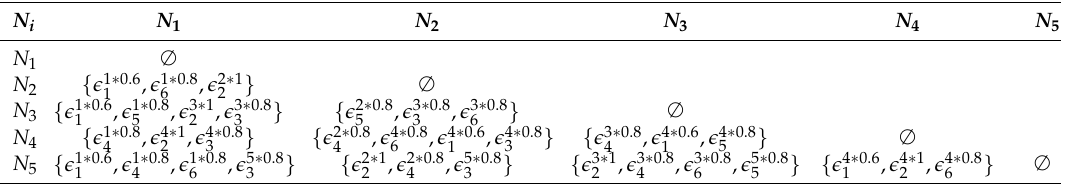
Table 10. The accuracy WSDM of Example 4.